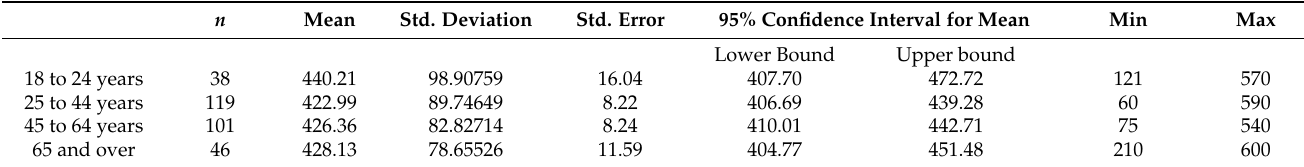
Table 8. Total sleep duration for age